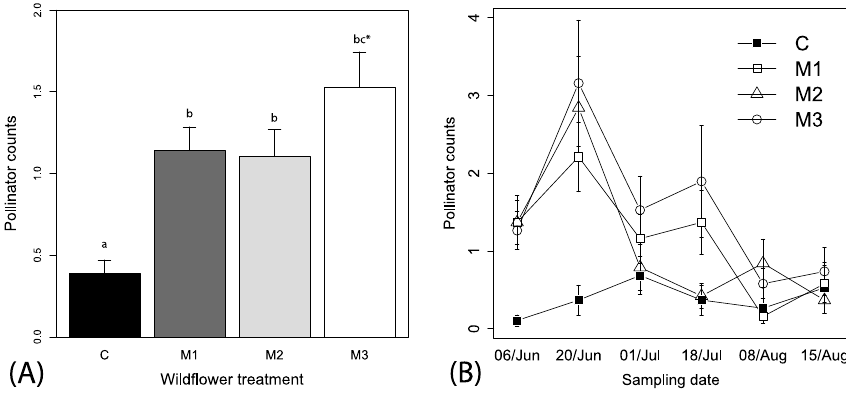
Figure 3B; slope coefficient estimate = − 0.10 (0.02), t -value = − 3.49, p < 0.001).